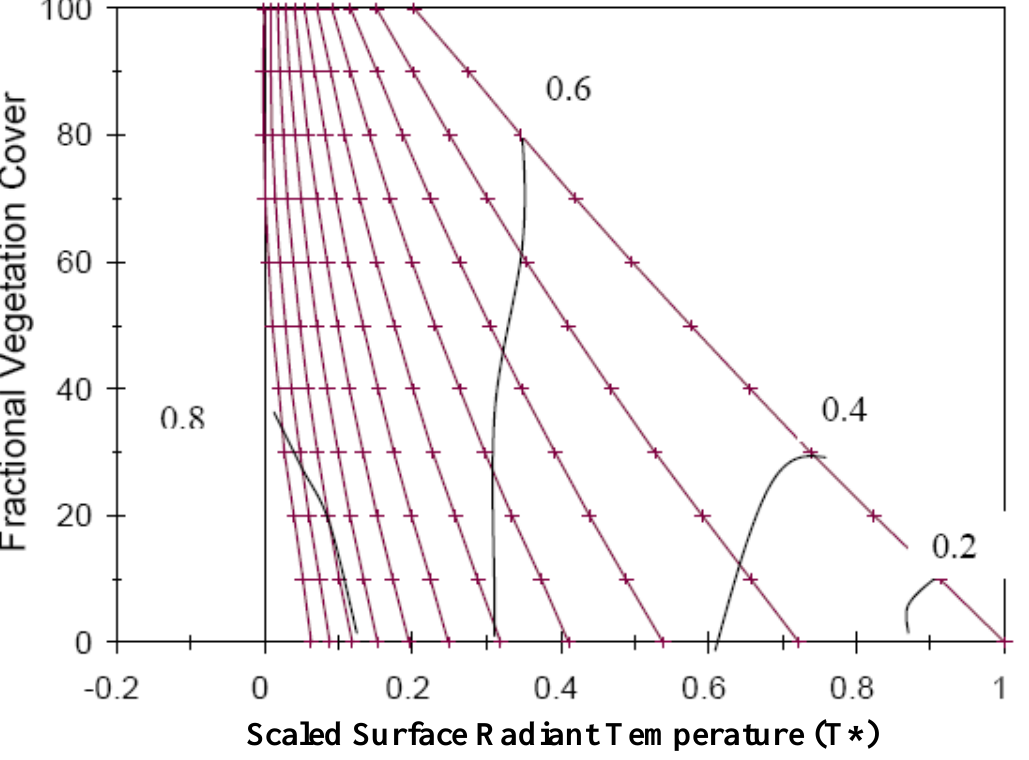
Figure 3. Model simulated triangle showing fractional vegetation cover (Fr; %) versus scaled radiant surface temperature (T*) (see definition in text). Slanting, nearly straight, lines represent the soil surface soil moisture availability, Mo labeled at intervals of 0.1, increasing from 0 on the right side (the warm edge).. Curved lines labeled as fractions represent the evapotranspiration fraction,